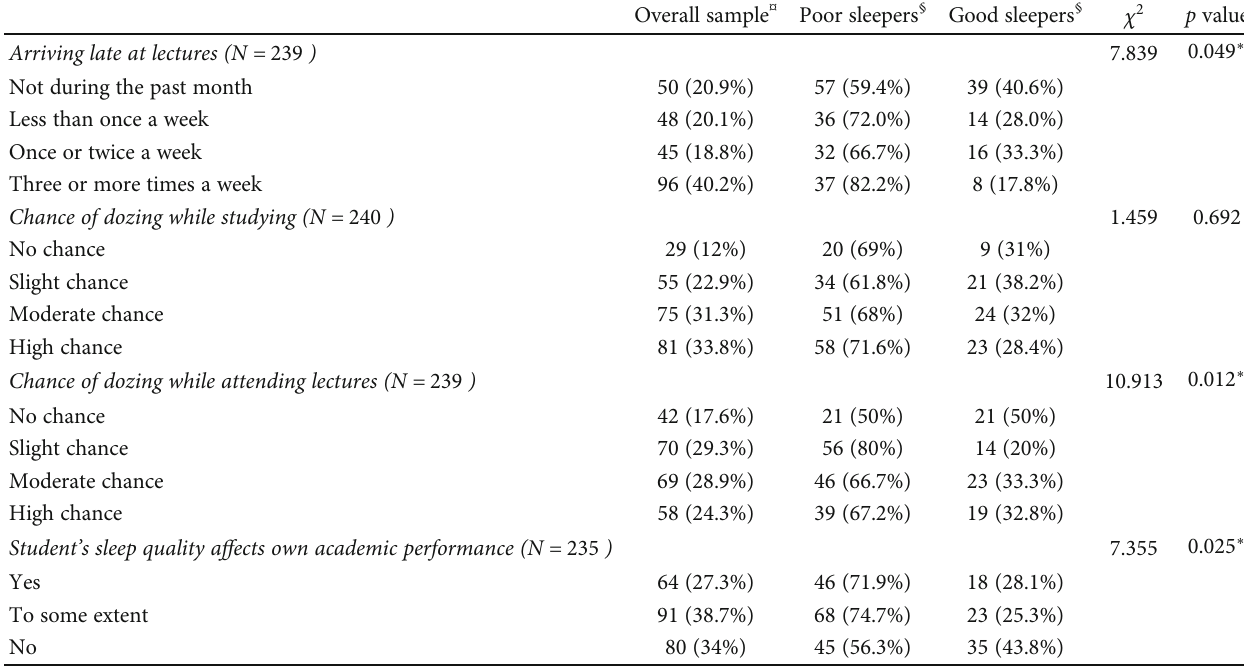
Table 5: Students ’ perception of the extent that poor sleep undermines their academic